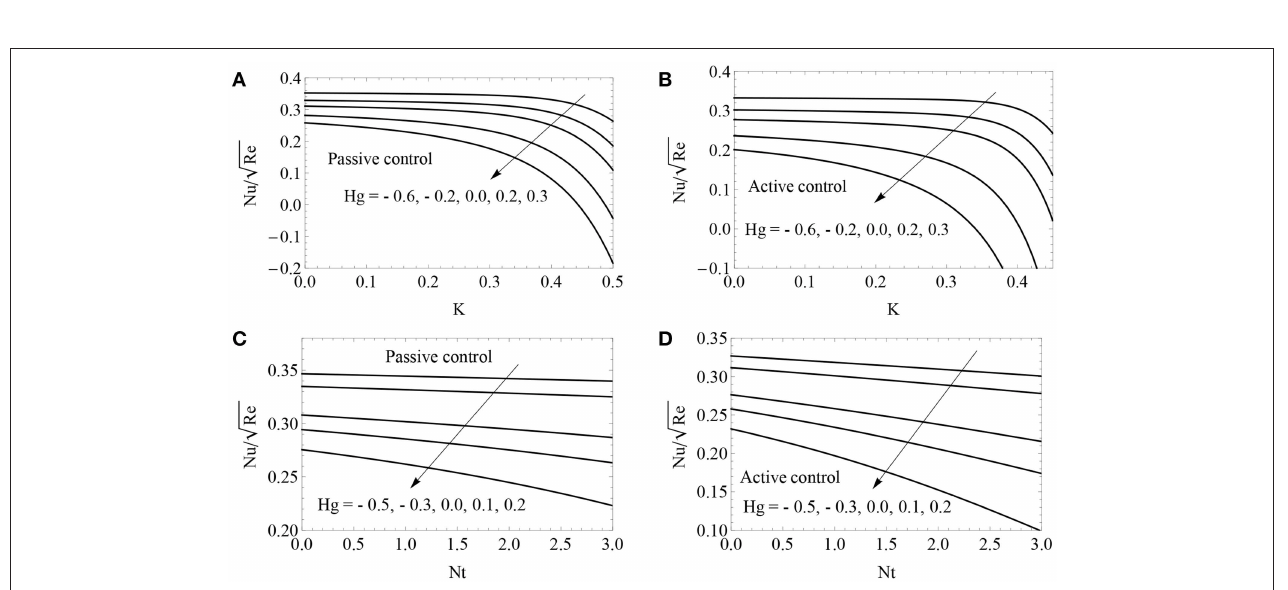
0.1, c 0.5, Nb 0.5 and Nt 0.2. = = = =